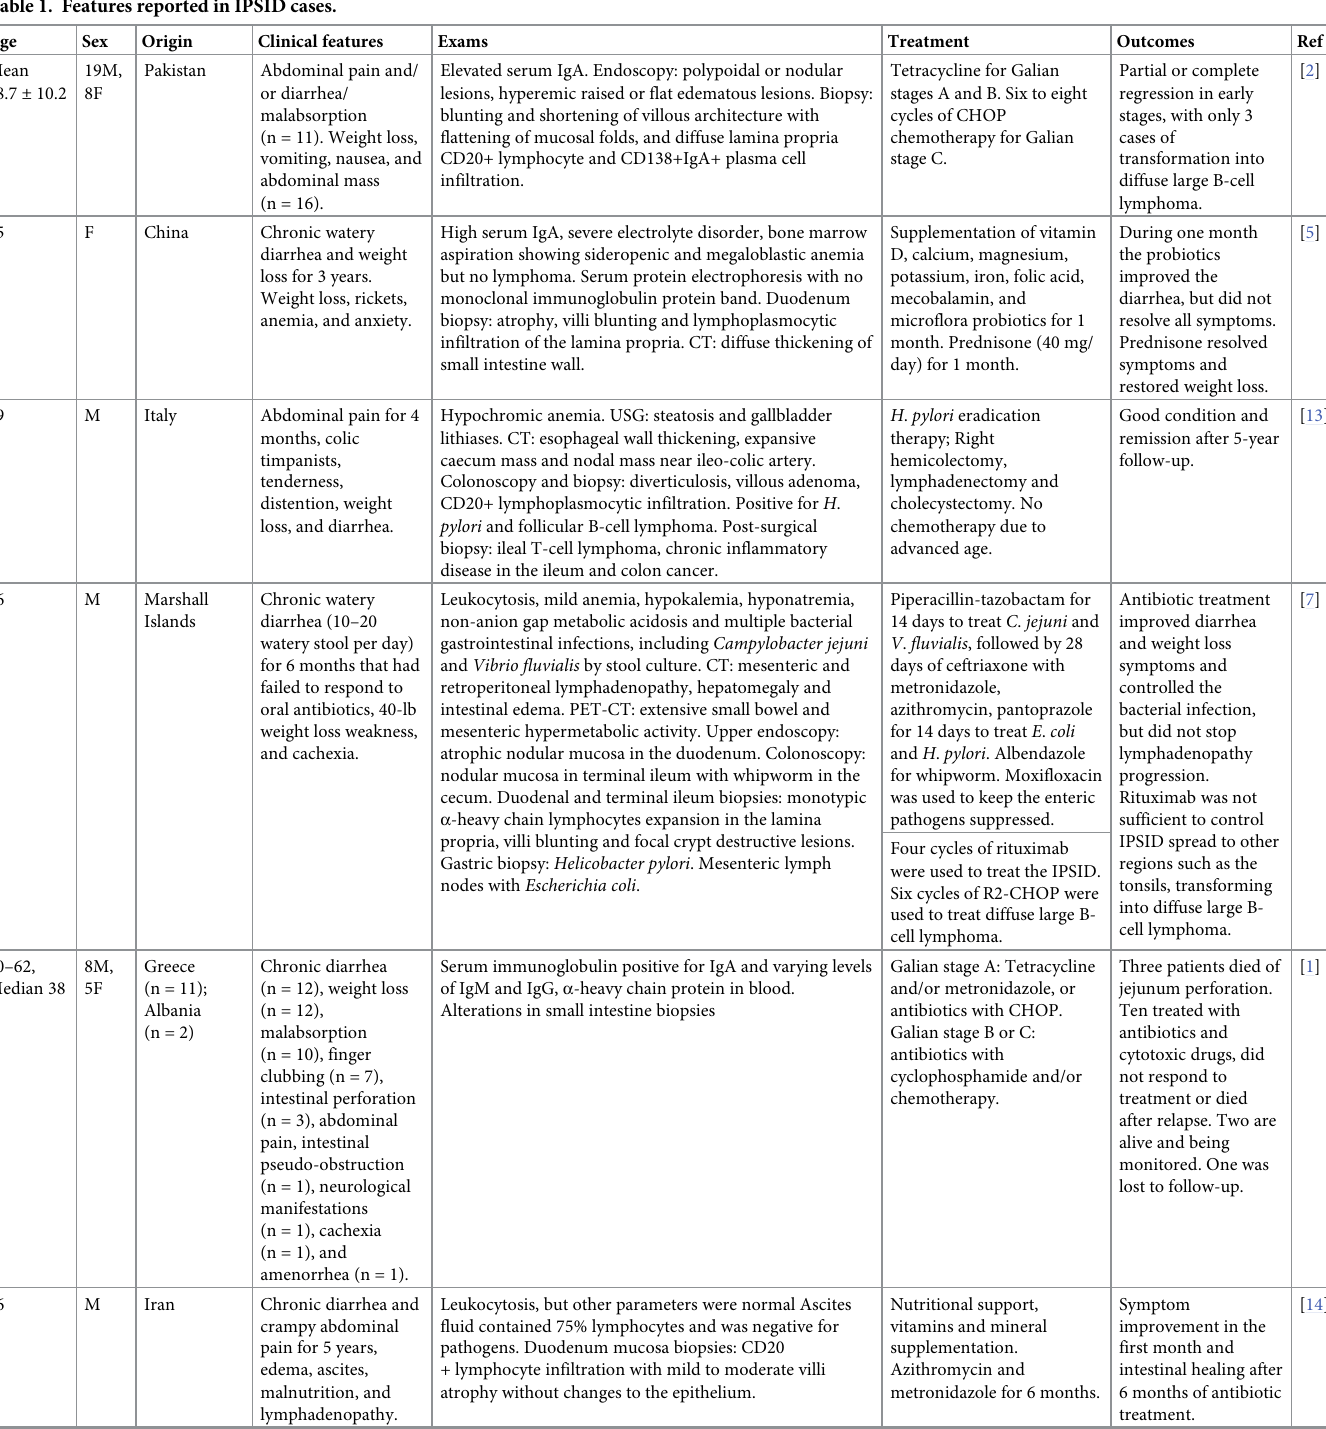
Table 1. Features reported in IPSID